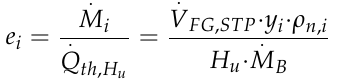
x CaO x MgO x SiO